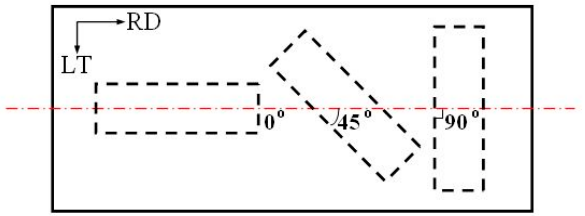
Figure 2. Schematic of tensile specimens with different orientations.